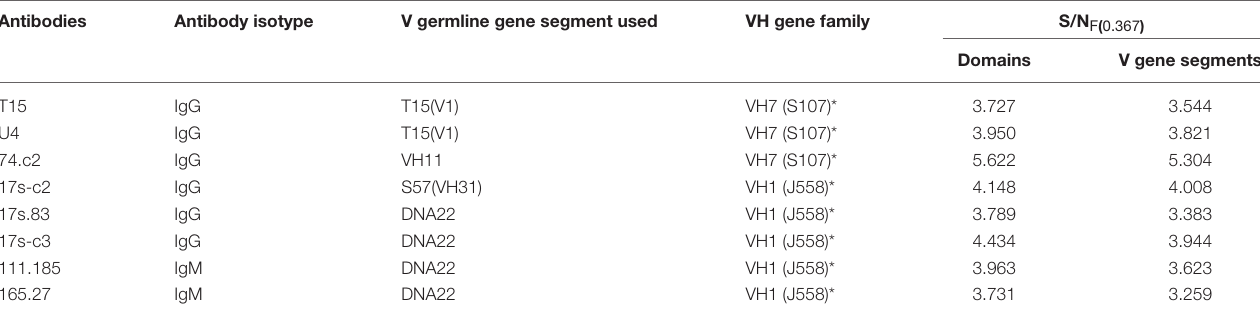
TABLE 1 | Contribution of antibody VH domains and corresponding V gene segments to S/N F(0.367) . Antibodies Antibody